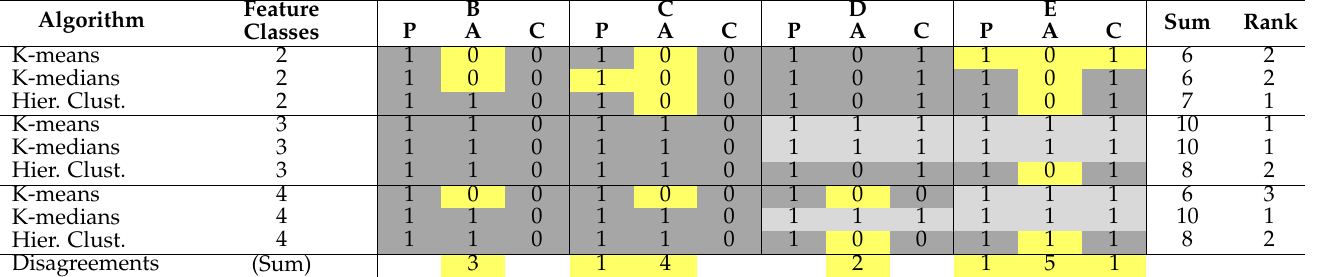
The panel evaluation for multiple polygon cluster maps produced using all Koala Coast subregional data is summarised in Table 13. Table 13. Visual evaluation of the clustering algorithms using all height data within the Koala Coast subregional group (6007 cells), scored using the same methods as Table 12. Maps were ranked according to how well four nominated features (B–E in Figure A11) were captured by each algorithm, each with 2, 3, and 4 classes. For all cells, there was 84.3% agreement by all panellists, and the panellists disagreed most often on whether the feature area (column A) was captured. K-means and K-medians are ranked equally for 3 classes, but K-medians is ranked higher for 4 classes.